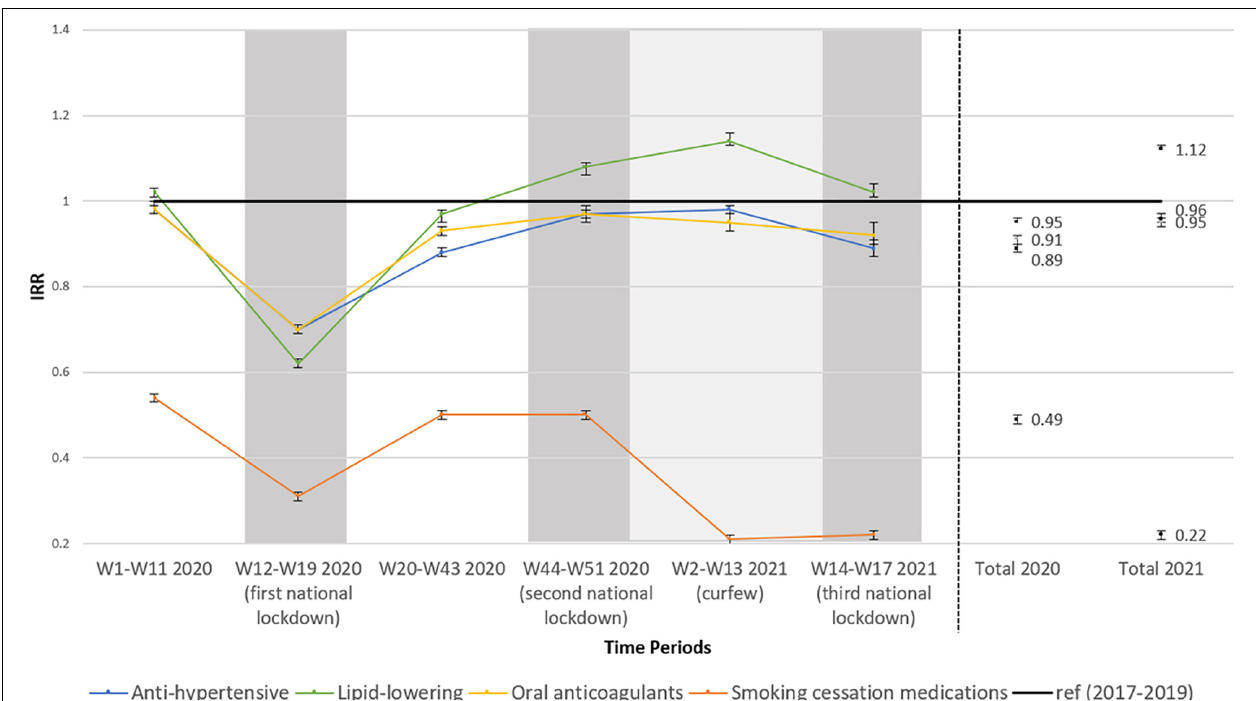
FIGURE 2 | Incidence rate ratio (IRR) a and 95% confidence intervals (95% CI) between rates of initiation of treatments, respectively in 2020 and 2021 compared to the rates of initiation in 2017–2019 according to sex by age group. a adjusted for age and 2017–2019 time trends; IRRs: Incidence rate ratios; Blue: men; Orange: